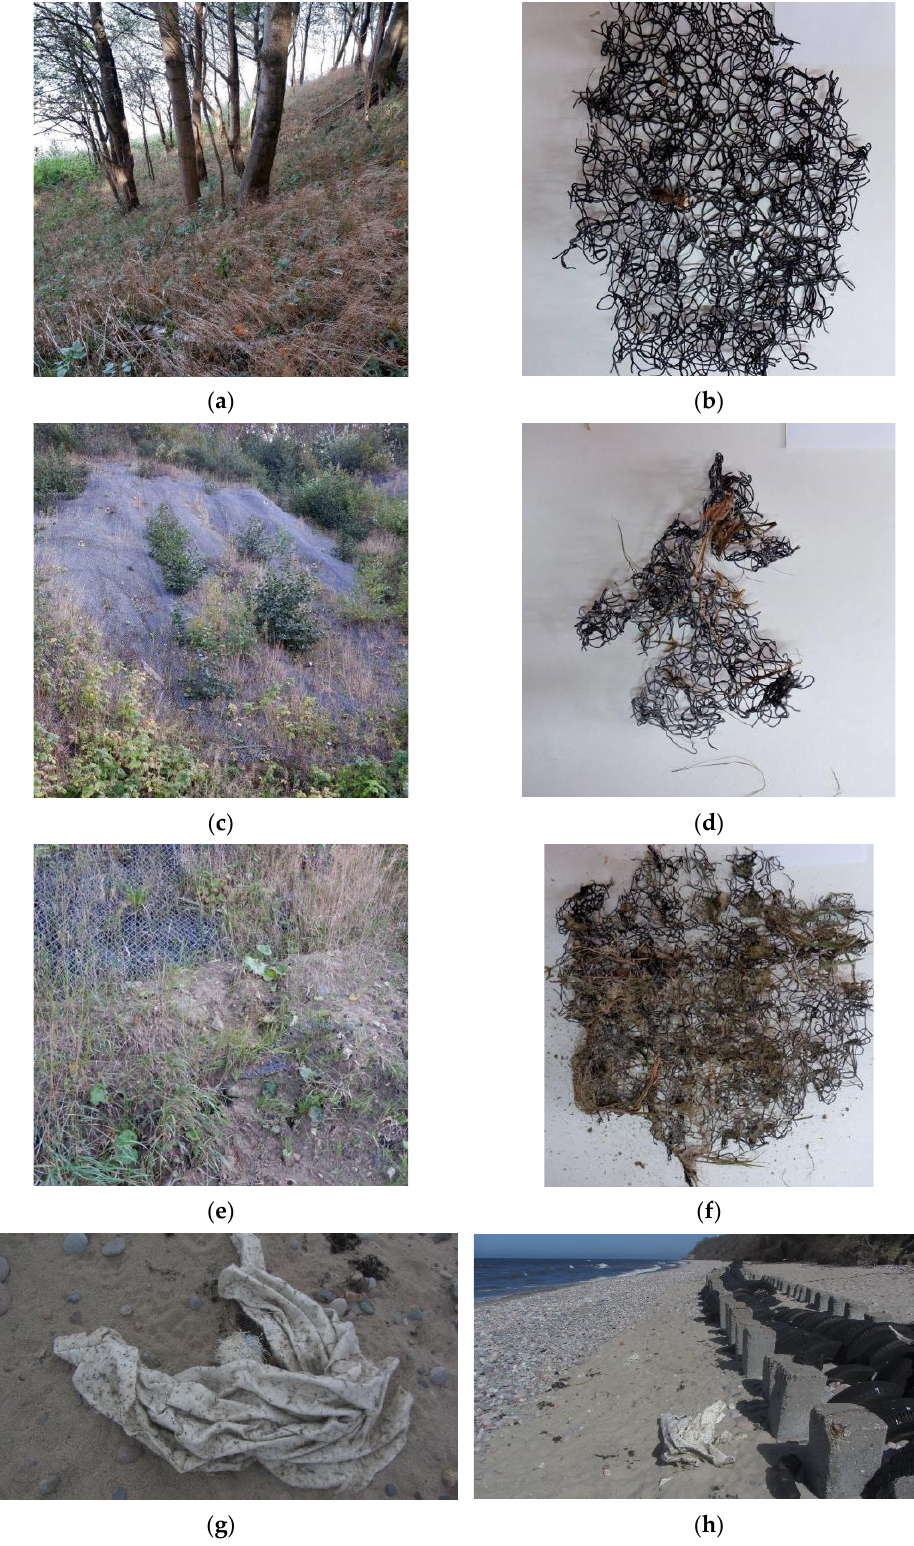
Figure 4. Various conditions in which the anti-slide coating is located: the upper, mostly grass-covered ( a ), and lower ( c ) (open and with small bushes) parts of the slope or covered by the landslide natural material ( e ). The samples of geomat taken in these locations ( b , d , f ). The pieces of geotextile Dornit released from the protection construction were sampled from the beach ( g , h